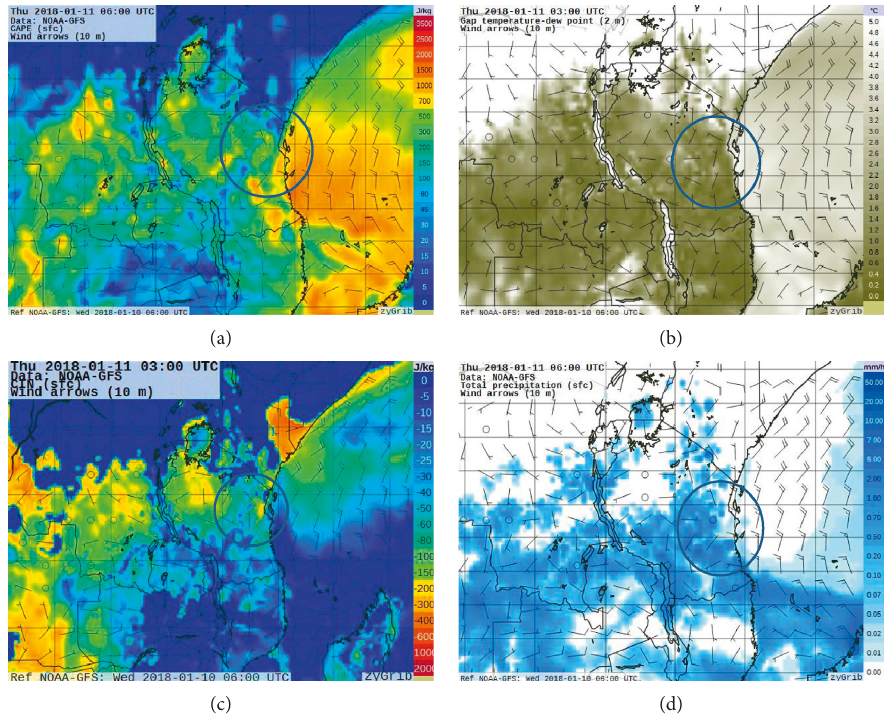
Figure 3: Convective available potential energy (J/kg) at 09:00 am (a); a gap between air temperature ( ° C) and dewpoint temperature ( ° C) (b); convective inhibition (J/kg) (c); total surface precipitation (mm) (d) all overlaid with wind at 10m (forecast data from NOAA-GFS on Wednesday 2018-01-10 0600 UTC and generated by using zyGRID-grib files visualization software, available at http://www.zygrib.org/). The circled area is the area of interest of explicitly low pressure and converging surface